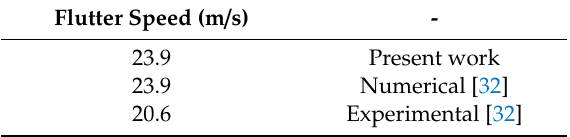
Table 4. Comparison of flutter speed for two-dimensional airfoil.